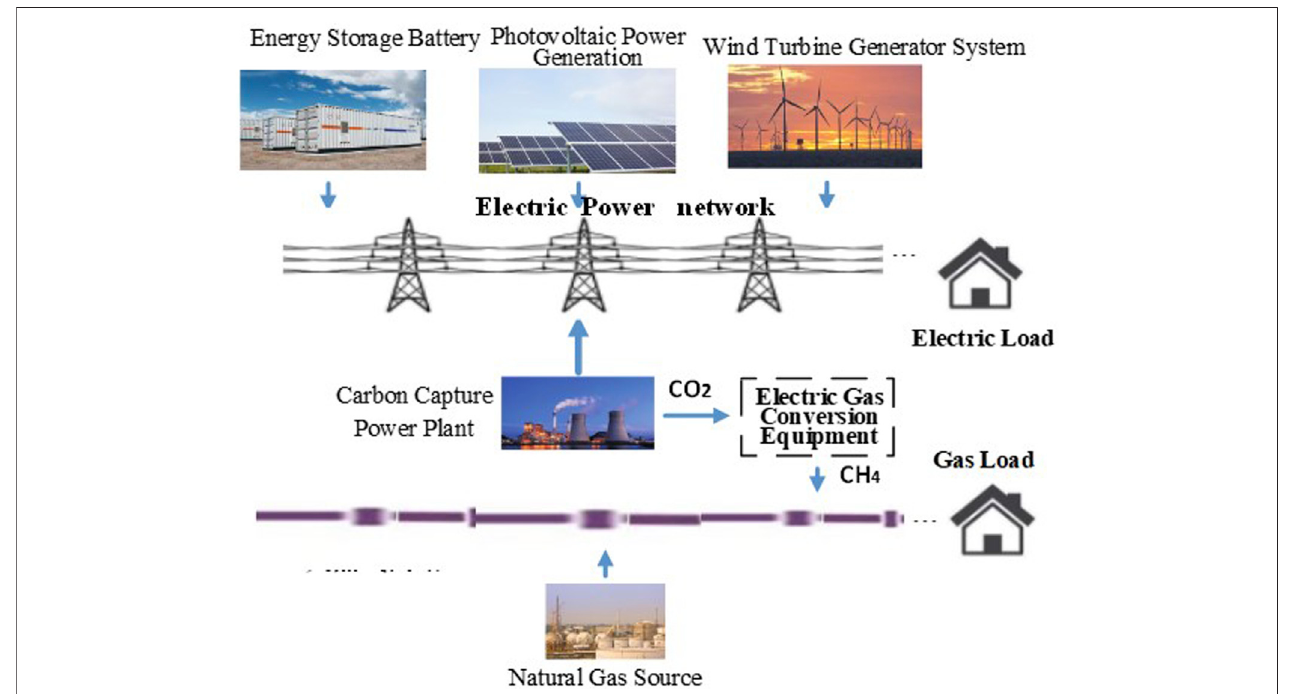
FIGURE 1 | Structure of the integrated energy